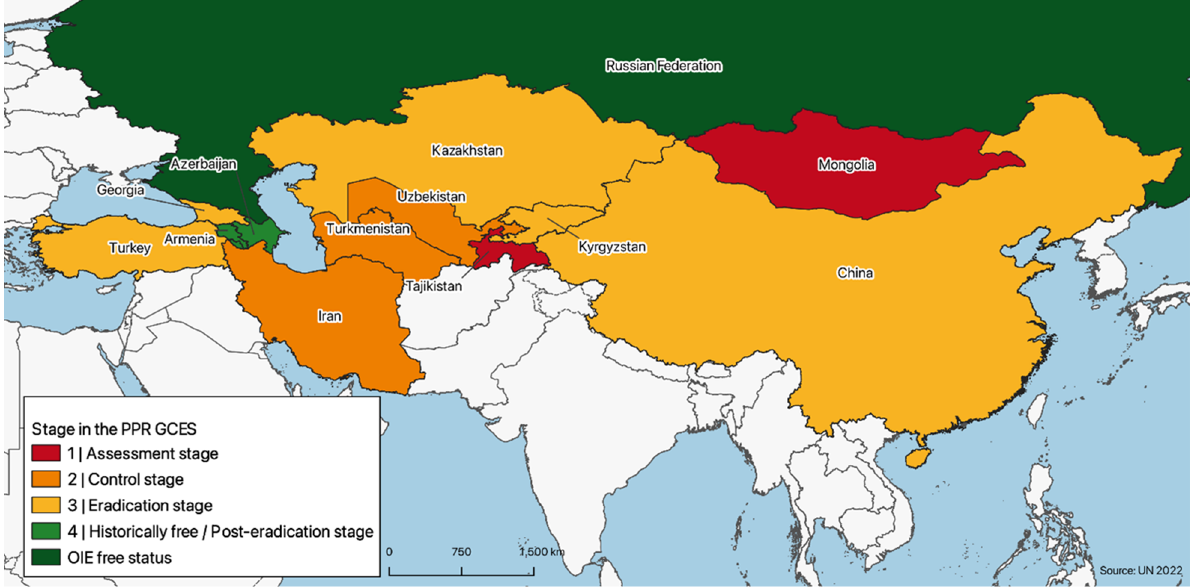
Figure 3. Map of the region detailing each country’s self-reported stage within the stepwise approach of the PPR GCES, updated in October 2021, except for Mongolia (last update in 2017) and Tajikistan (last update in